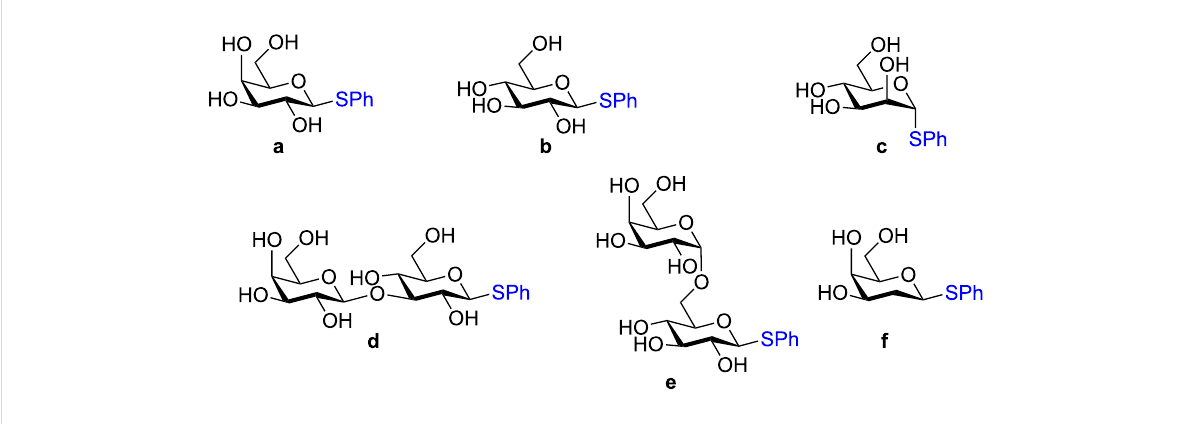
Figure 2: Unprotected glycosyl donors used for the Lewis acid-catalyzed protecting group-free glycosylation reaction to access 1,2- cis glycosides.